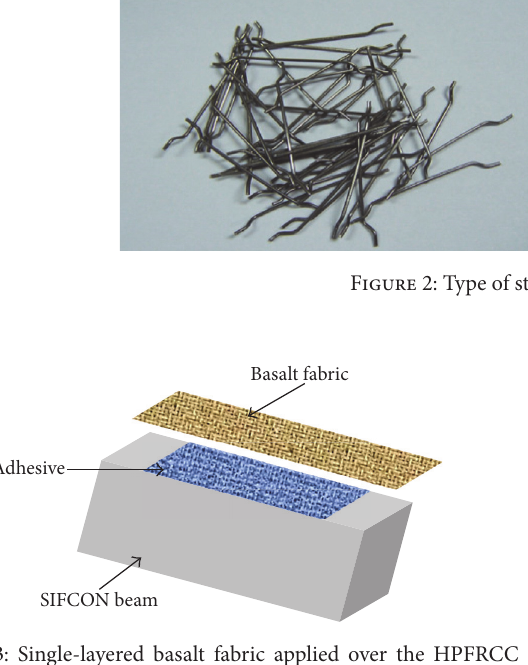
Figure 3: Single-layered basalt fabric applied over the HPFRCC beam with adhesive layer.